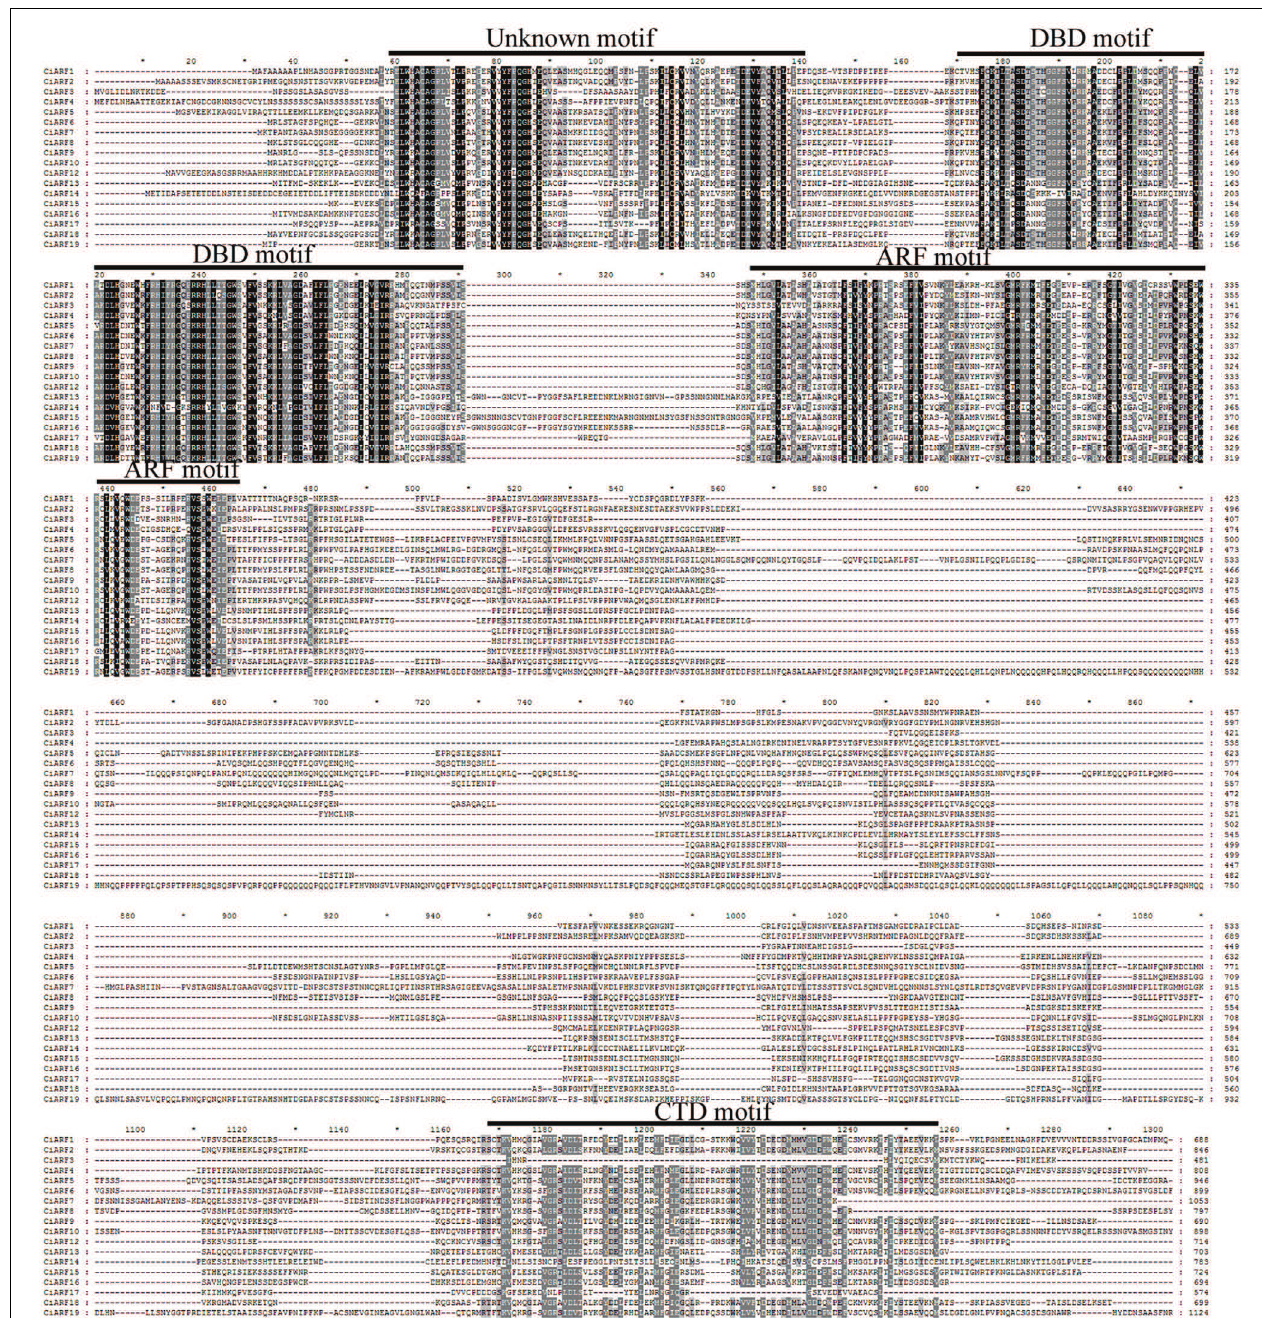
FIGURE 2 | Multiple sequence alignment of the CiARF proteins obtained with ClustalX Conserved domains of CiARF proteins are marked by the overline.